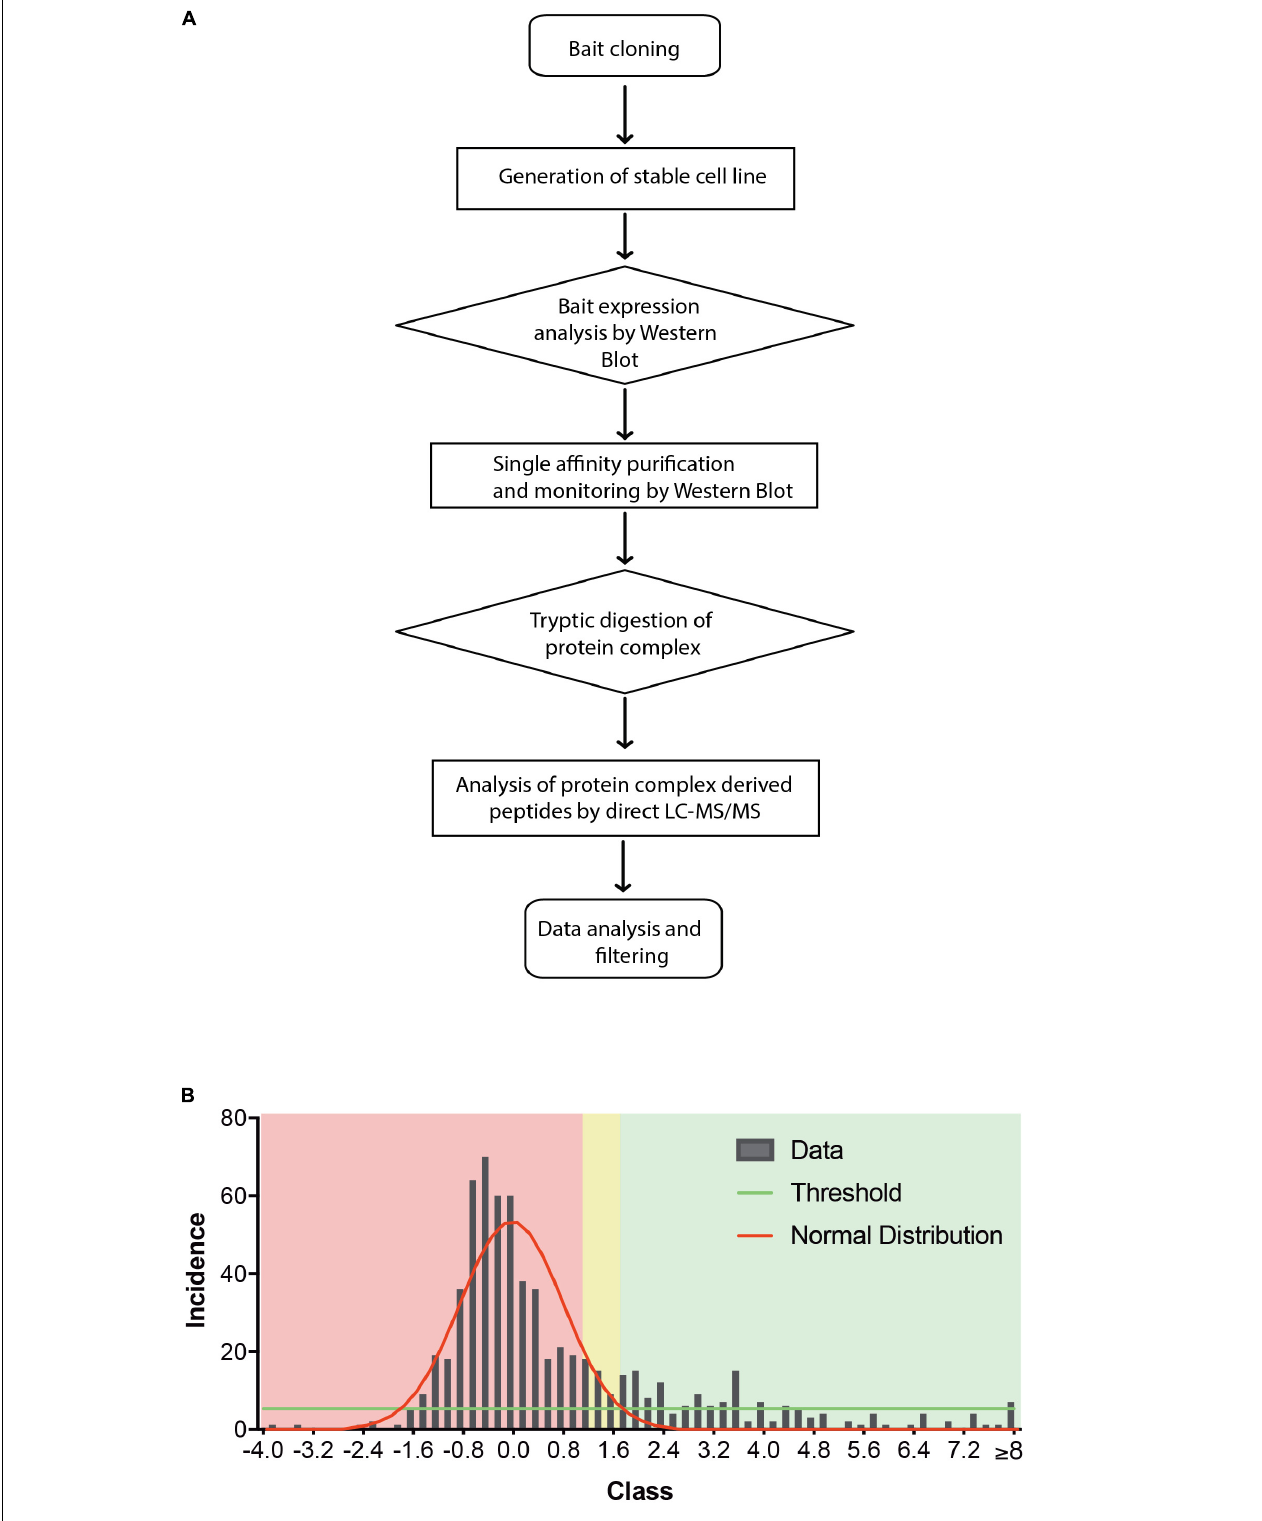
FIGURE 1 | (A) Flow chart of CaptiVate screening procedure. The bait CB2 was amplified and sub-cloned into the expression vector pN-TGSH (Dualsystems). The bait sequence was verified by sequencing. For constitutive expression, the bait was transfected into HEK293 Flp-In cells and selected for stable integration.